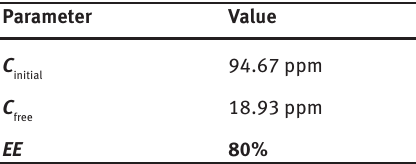
Table 2 : Encapsulation parameter in sesame